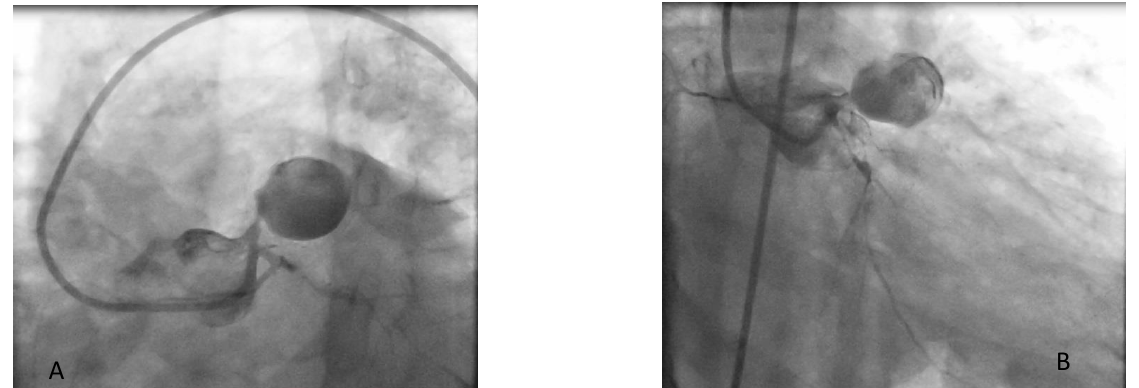
Figure 2. A.Left anterior oblique caudal view (picture above) and B. right anterior oblique caudal view (picture below) of the left coronary angiogram showing the aneurysm of the left anterior descending artery